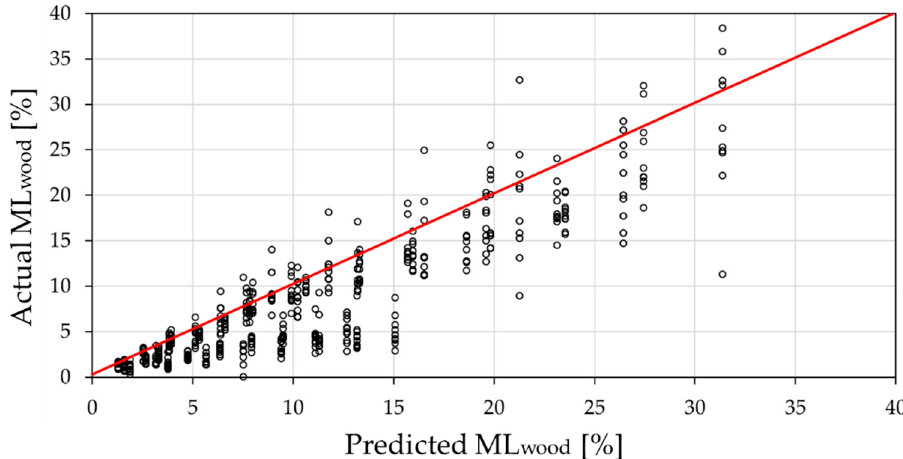
Figure 6. Relationship between actual and predicted values of an independent subset of ML wood data describing alternating temperature-induced conditions. The red line shows an ideal, 1:1 prediction accuracy of the cumulative total daily dose model to which the predicted values were compared. R 2 = 0.65.